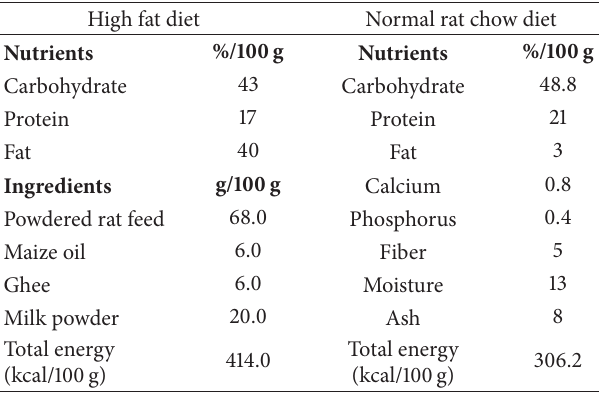
Table 1: Composition of high fat diet and normal rat chow